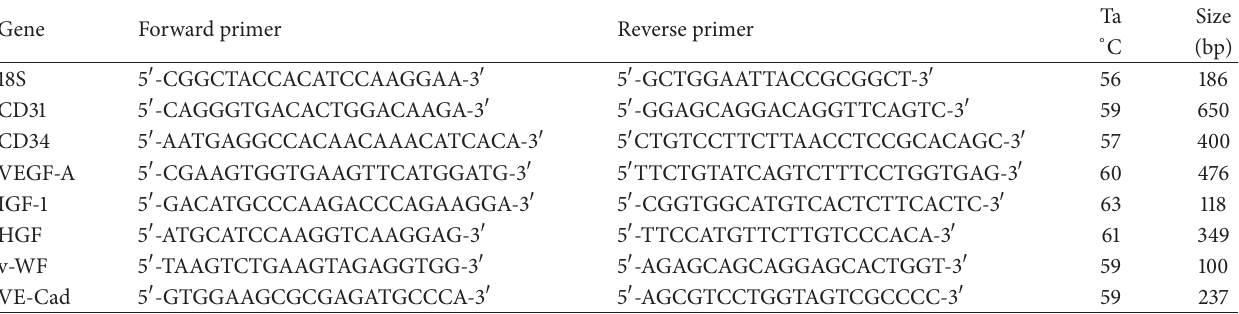
Table 1: Primer sequence used for semiquantitative RT-PCR